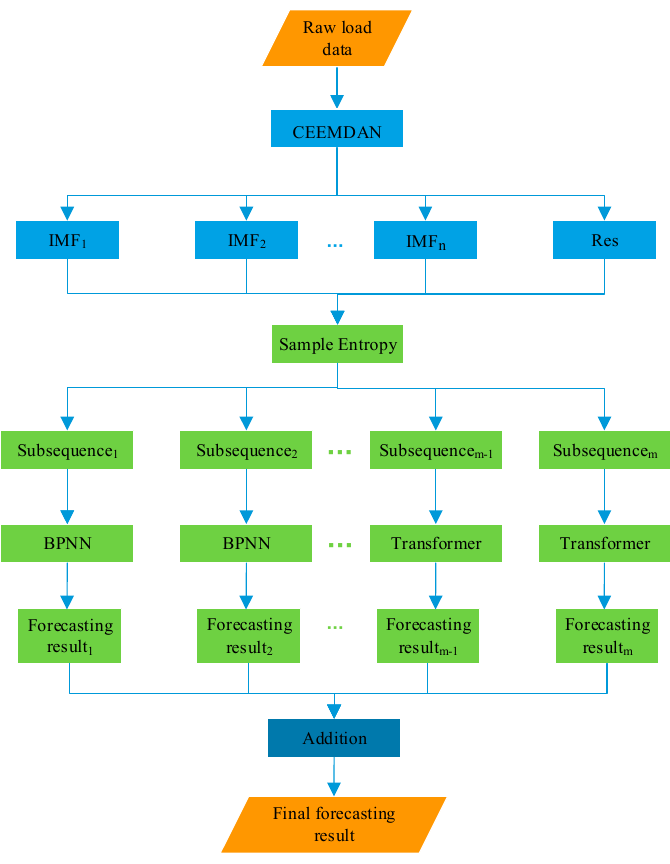
Figure 1. The flowchart of the CEEMDAN-SE-BPNN-Transformer Model.